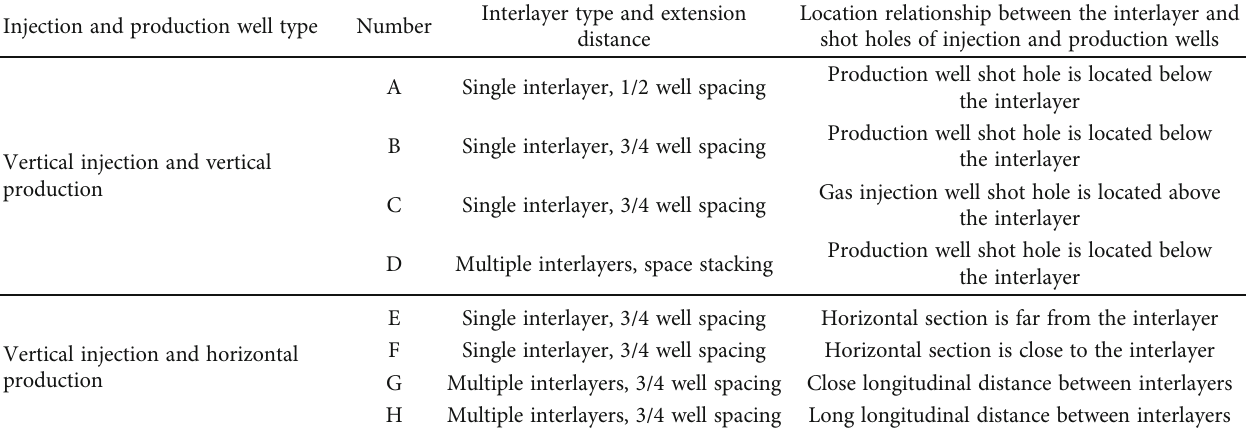
Table 8: Relationship between di ff erent combinations of well types, seepage barriers, and injection well shot hole locations. Injection and production well type Number